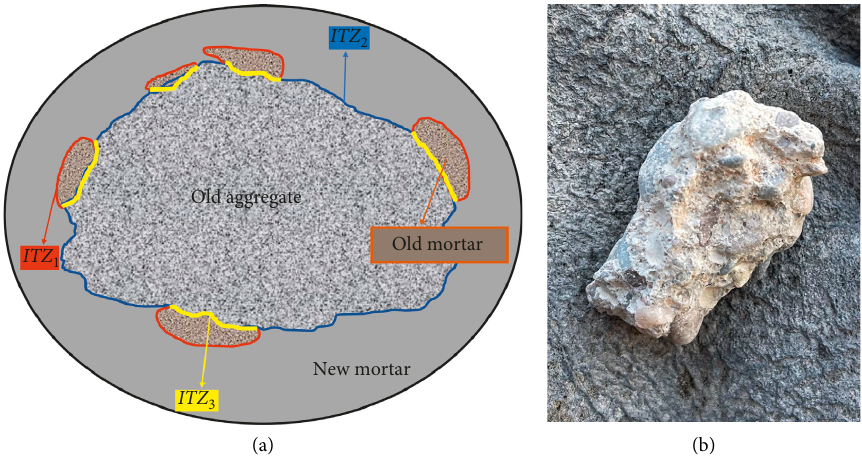
Figure 2: RCA; (a) Multiple interface structure of RCA; (b) Real graph.